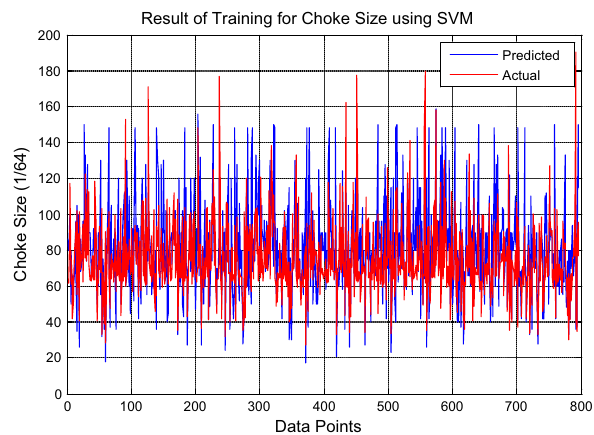
Fig. 24 Correlation between the actual and the predicted choke size for training data (FN) ( R = 0.81)